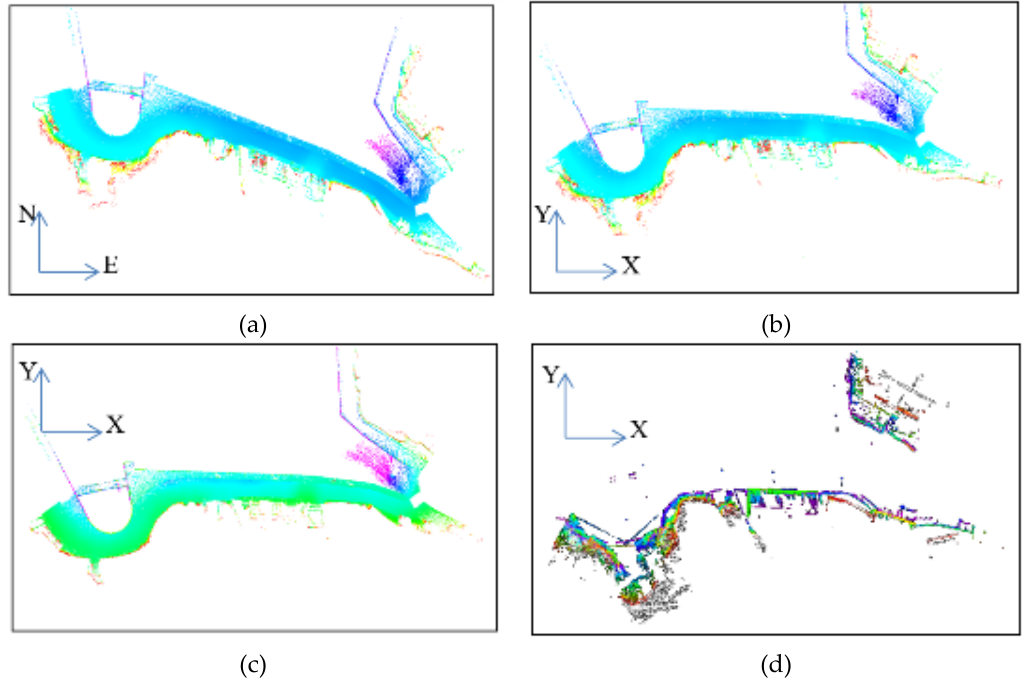
Figure 3. ( a ) Point cloud corresponding to slice 1 in Test Site 1 in UTM coordinate system; ( b ) after the coordinate system change; ( c ) filtering in negative; and ( d ) positive heights.